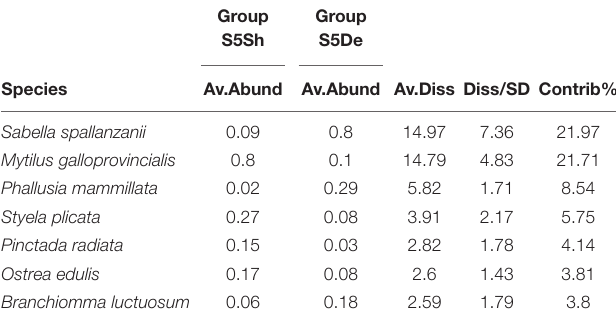
TABLE 3 | SIMPER analysis of group S5 of vertical collectors in relation with depth.